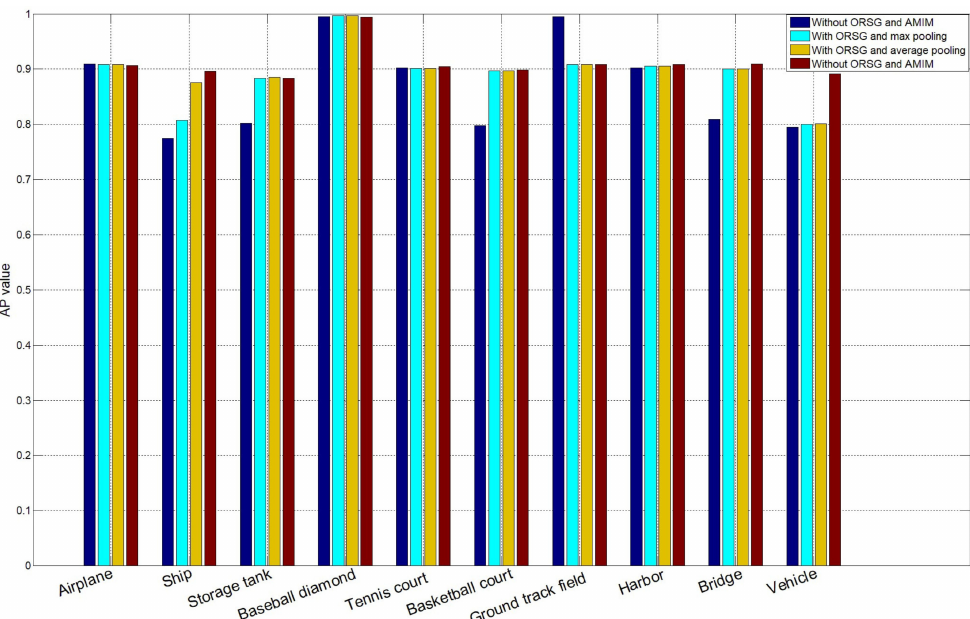
Figure 15. The AP value for different targets under various context fusion networks. (The evaluation metric: AP; Dataset: NWPU-VHR (train: 20%, val: 20%, test: 60%)).